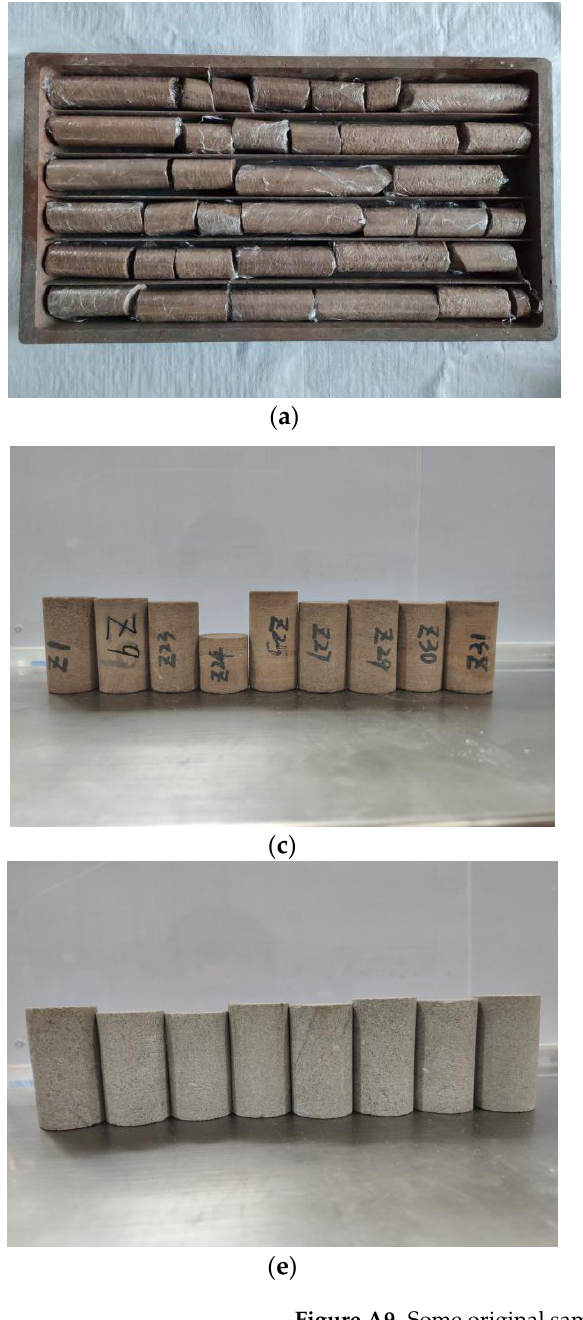
Figure A8. The experimental devices used in the present research. ( a ) STY-2 gas permeability and porosity meters. ( b ) Mastersizer 3000E laser grain size analyzer. ( c ) MAP 9500 mercury porosimeter (overall photo). ( d ) MAP 9500 mercury porosimeter (photo enlarged locally). ( e ) Zeiss Imaging-2M polarizing microscope. ( f ) Nova Nano 450 scanning electron microscopy.